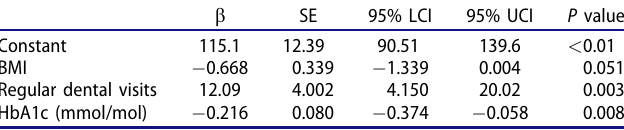
Table 5. Multiple linear regression analysis of exposure variables on the Met Need